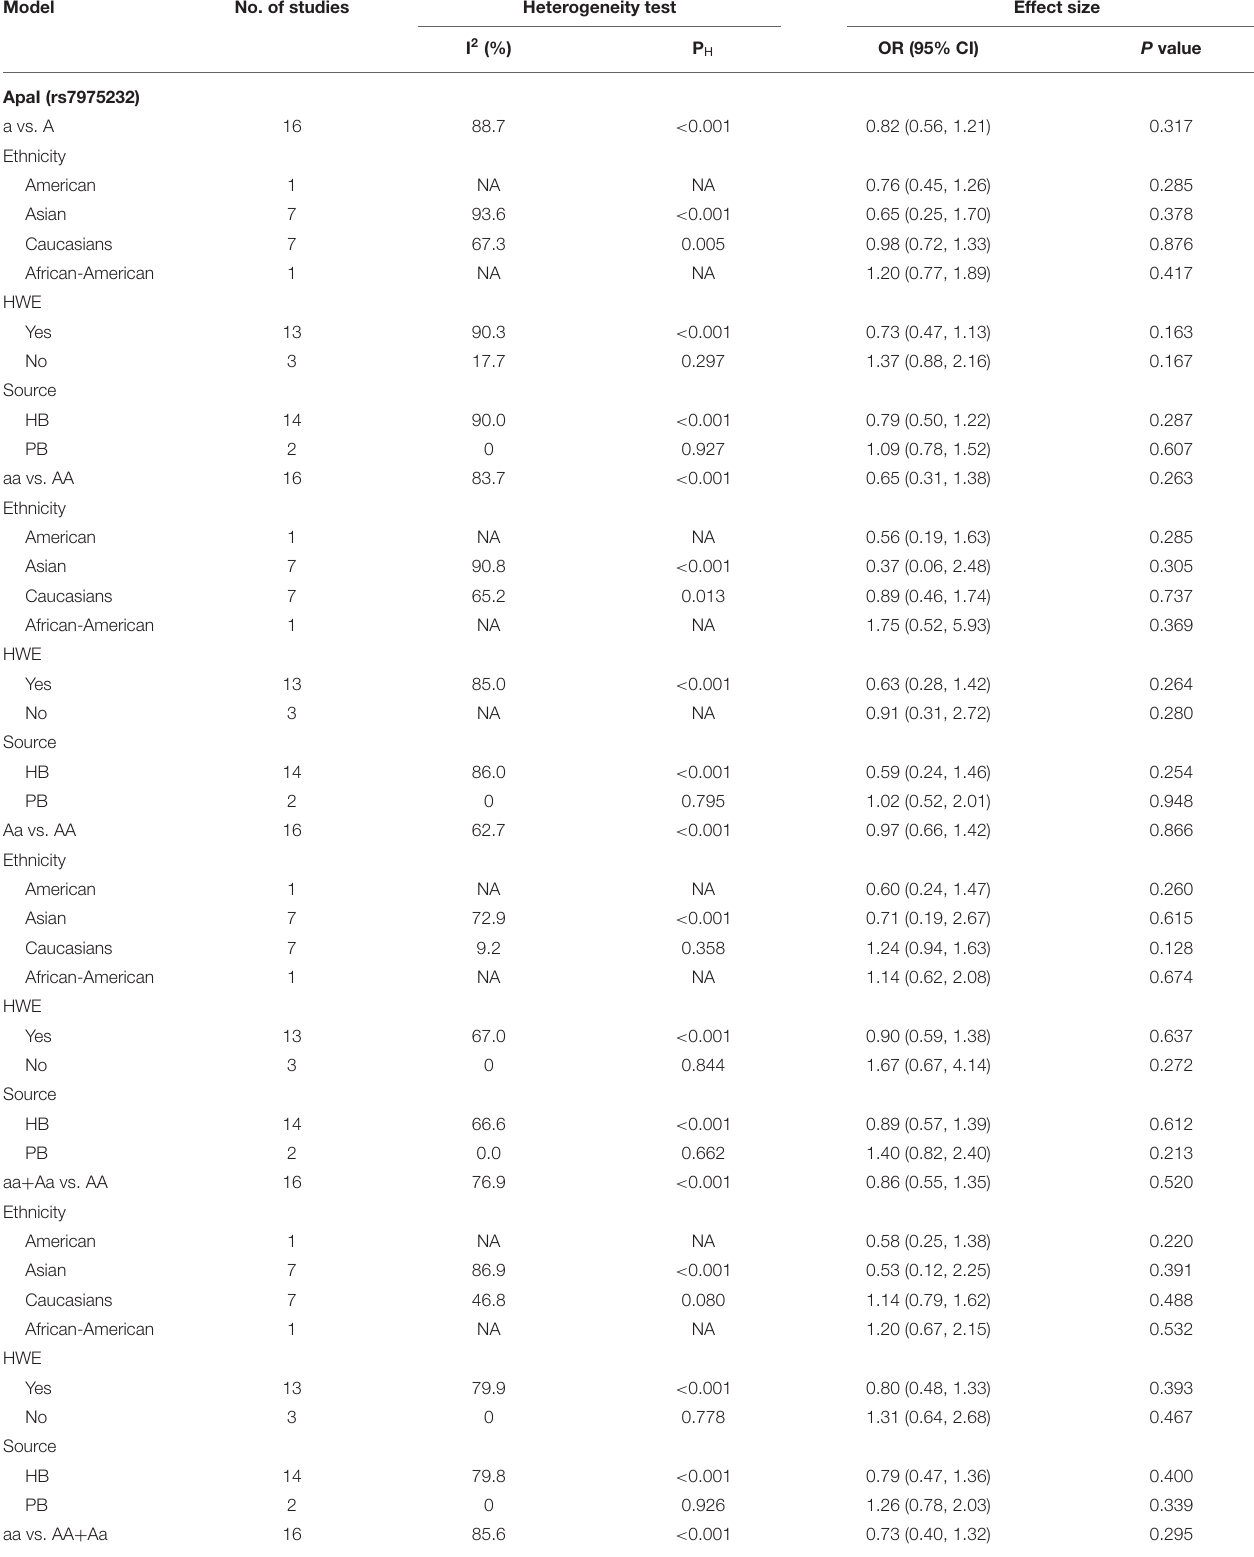
TABLE 4 | Outcomes of the subgroup analysis.